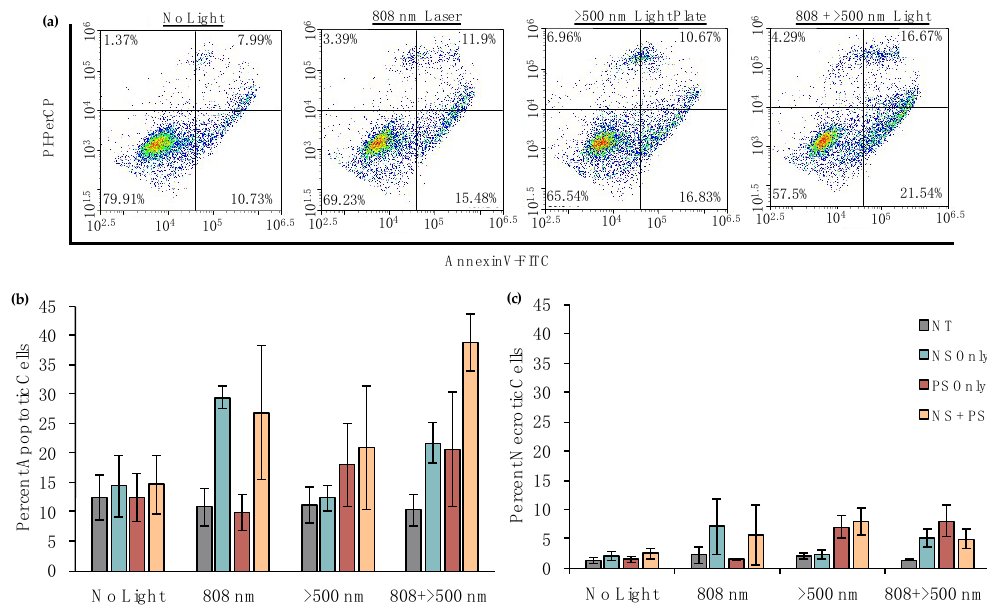
Figure 6. Analysis of the mechanism of cell death using AnnexinV/PI assays following treatment with PEG-NSs and/or Pd[DMBil1]-PEG 750 photosensitizers (PSs) and each light source. ( a ) Representative scatter plots showing the percentage of cells undergoing apoptosis versus necrosis following treatment with Pd[DMBil1]-PEG 750 and PEG-NSs with each light source; ( b ) Percentage of apoptotic cells; and ( c ) Percentage of necrotic cells following treatment. Data shown are compiled from four independent experiments.